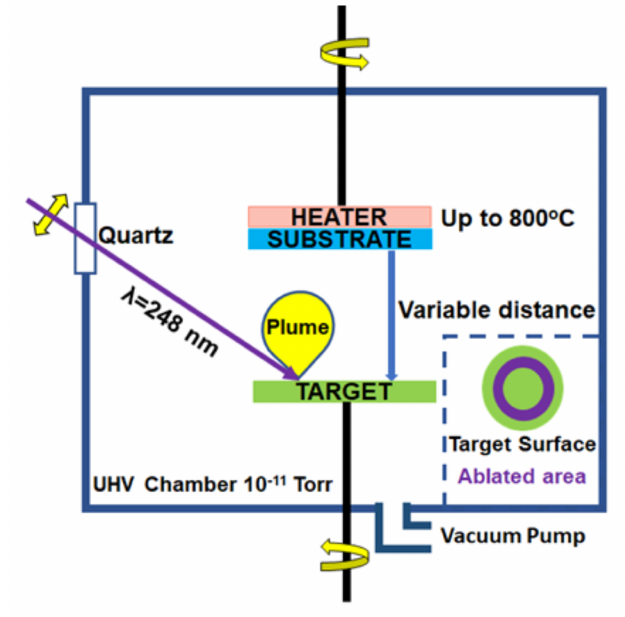
Figure 1. Schematics of the laser ablation (PLD)